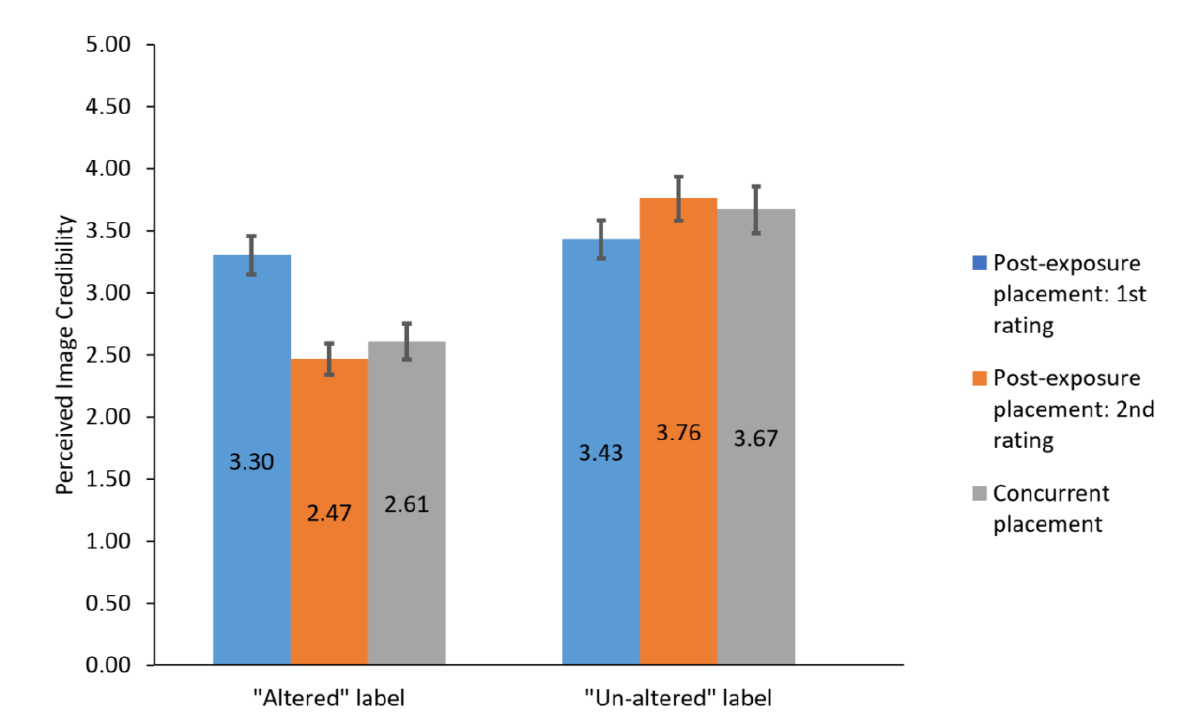
Figure 3. Perceived image credibility in post-exposure condition (blue and orange bars) and concurrent condition (gray bars). Higher numbers represent greater perceived credibility. Paired t-tests showed that participants’ second ratings (orange bars) were significantly different from their first ratings (blue bars), as a result of the forensic label, but they were not different from those of the concurrent condition (gray bars). Error bars represent 95% confidence intervals for the